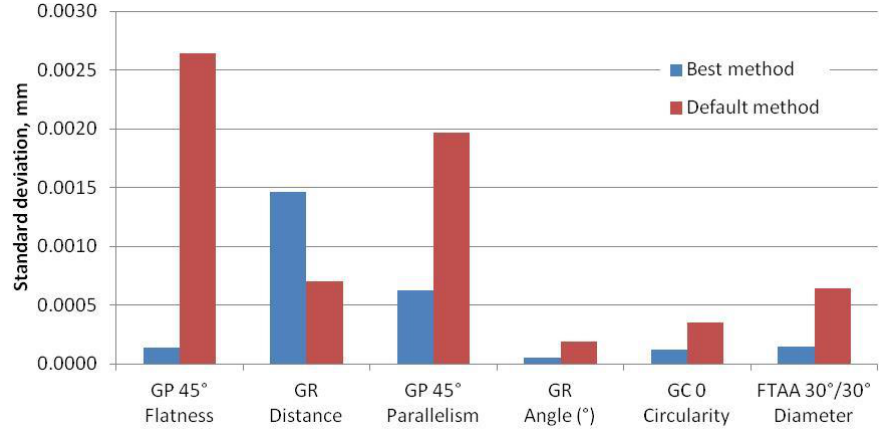
Figure 9. The standard deviations for the measurements of the multi-feature check using the default and the best path control algorithms.